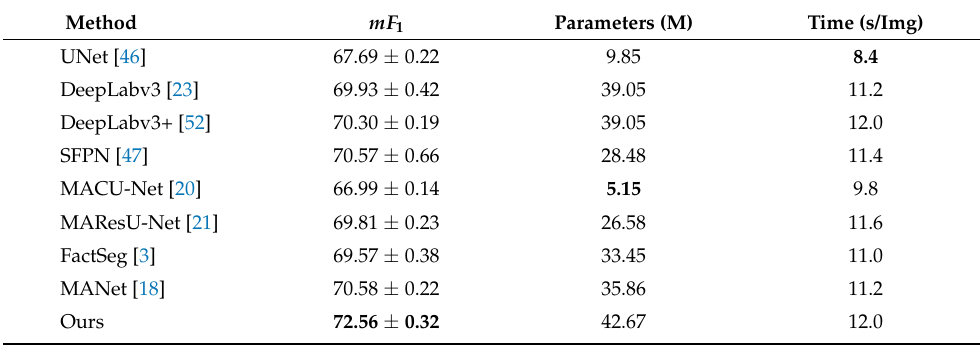
Table 7. The efficiency comparison of PGNet and SOTA on the ISPRS Vaihingen dataset. The best results are highlighted in bold